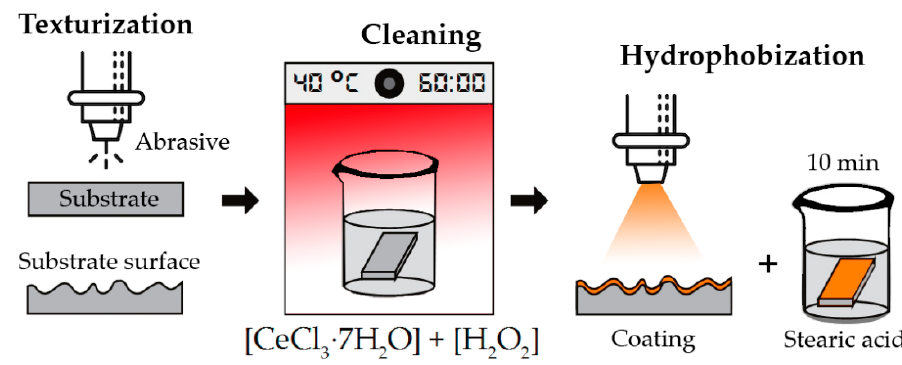
Figure 3. Scheme for the deposition of cerium-based coatings by immersion using cerium chloride.